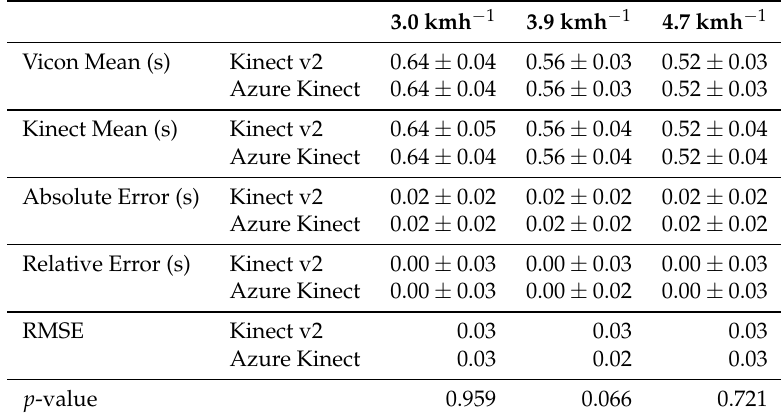
Table 6. Step time gait parameter